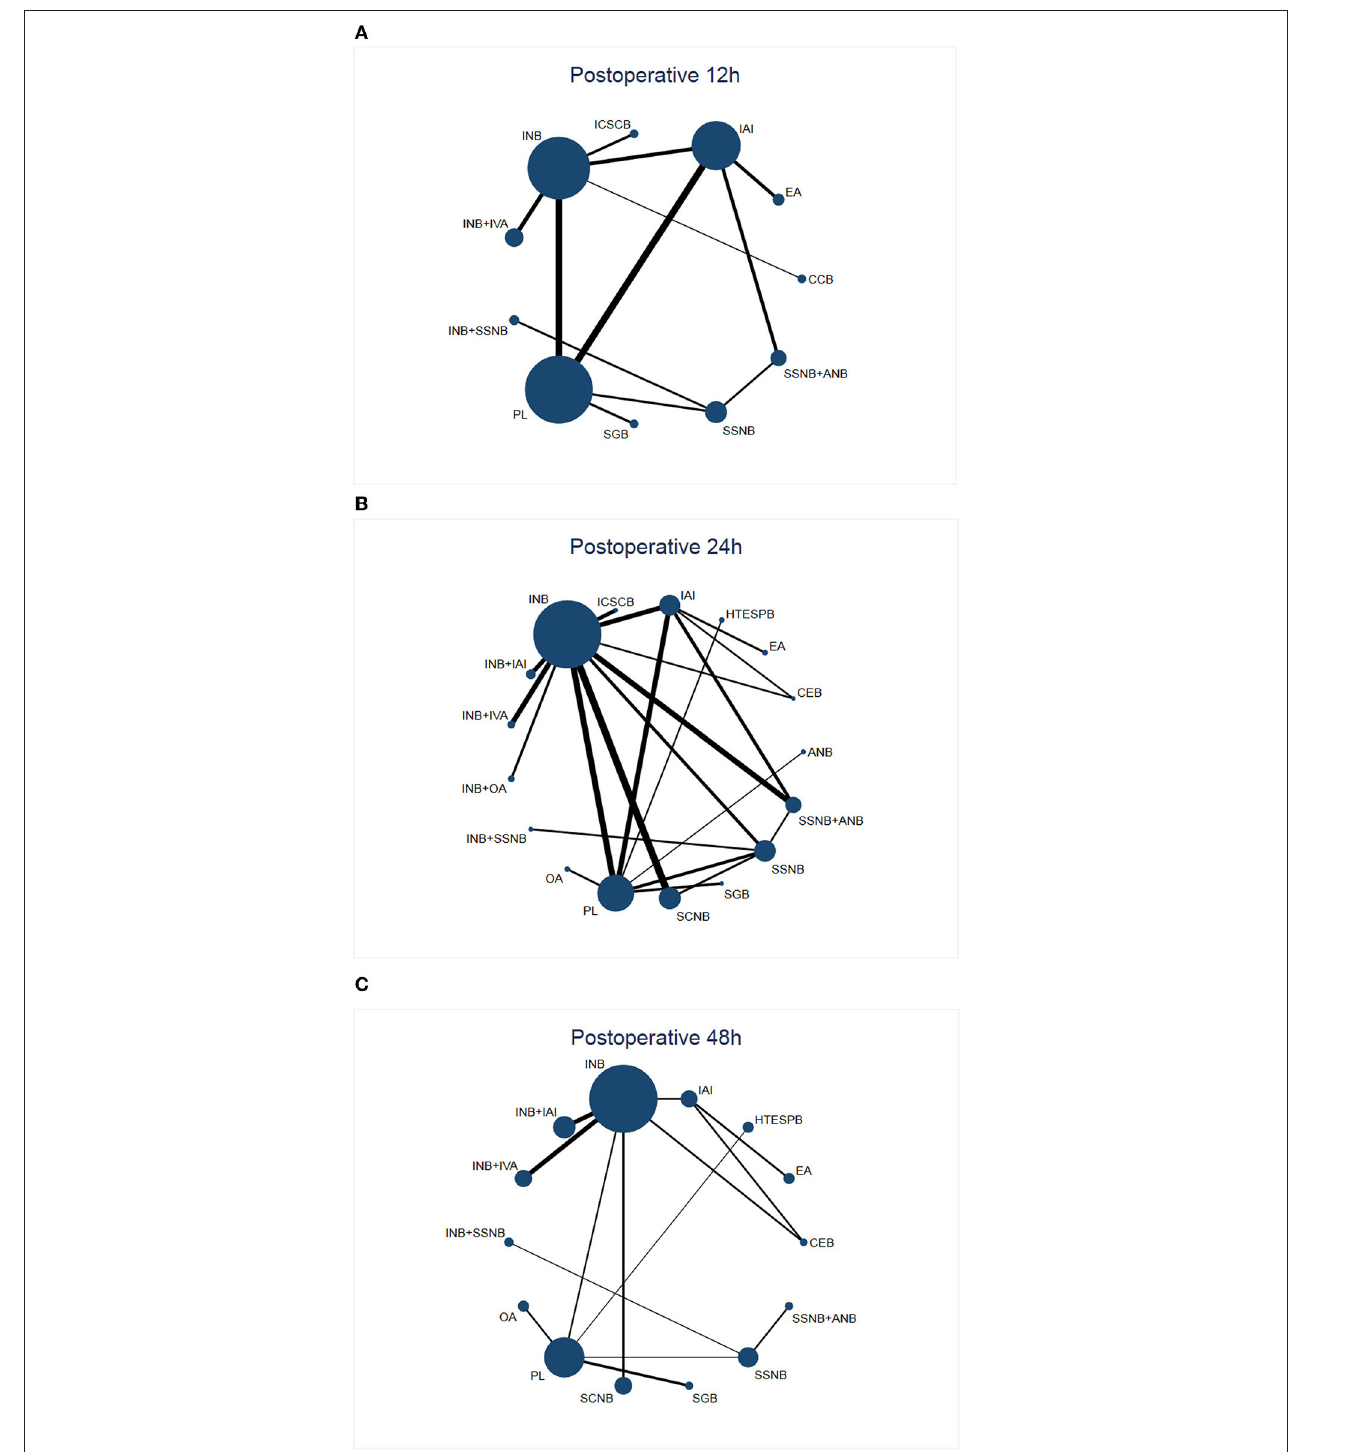
FIGURE 2 | Network plot of treatment comparisons. (A) (Network 1) Network plot of treatment comparisons for postoperative 12 h. The size of the blue area indicates the sample size of each group, and the thickness indicates the results of comparisons between two groups. (B) (Network 2) Network plot of treatment comparisons for postoperative 24 h. The size of the blue area indicates the sample size of each group, and the thickness indicates the results of comparisons between two groups. (C) (Network 3) Network plot of treatment comparisons for postoperative 48 h. The size of the blue area indicates the sample size of each group, and the thickness indicates the results of comparisons between two groups. INB, interscalene nerve block; SSNB, suprascapular nerve block; SCNB, supraclavicular nerve block; ICSCB, infraclavicular-suprascapular blocks; CCB, costoclavicular blocks; ANB, axillary nerve block; IAI, intra-articular injection; EA, external application; IVA, intravenous administration; SGB, stellate ganglion block; PL, placebo; HTESPB, high thoracic erector spinae plane block; CEB, cervical epidural block; ANB, axillary nerve block; OA, oral administration. Frontiers in Medicine |